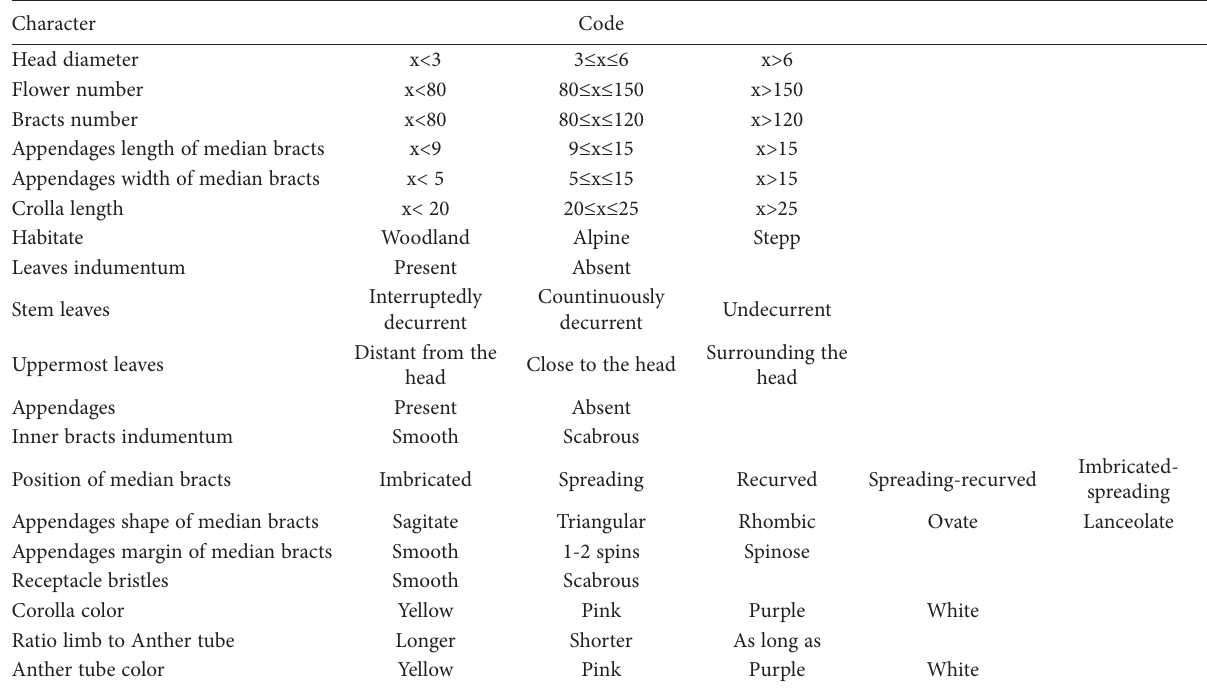
Table 2. Morphological characters and their